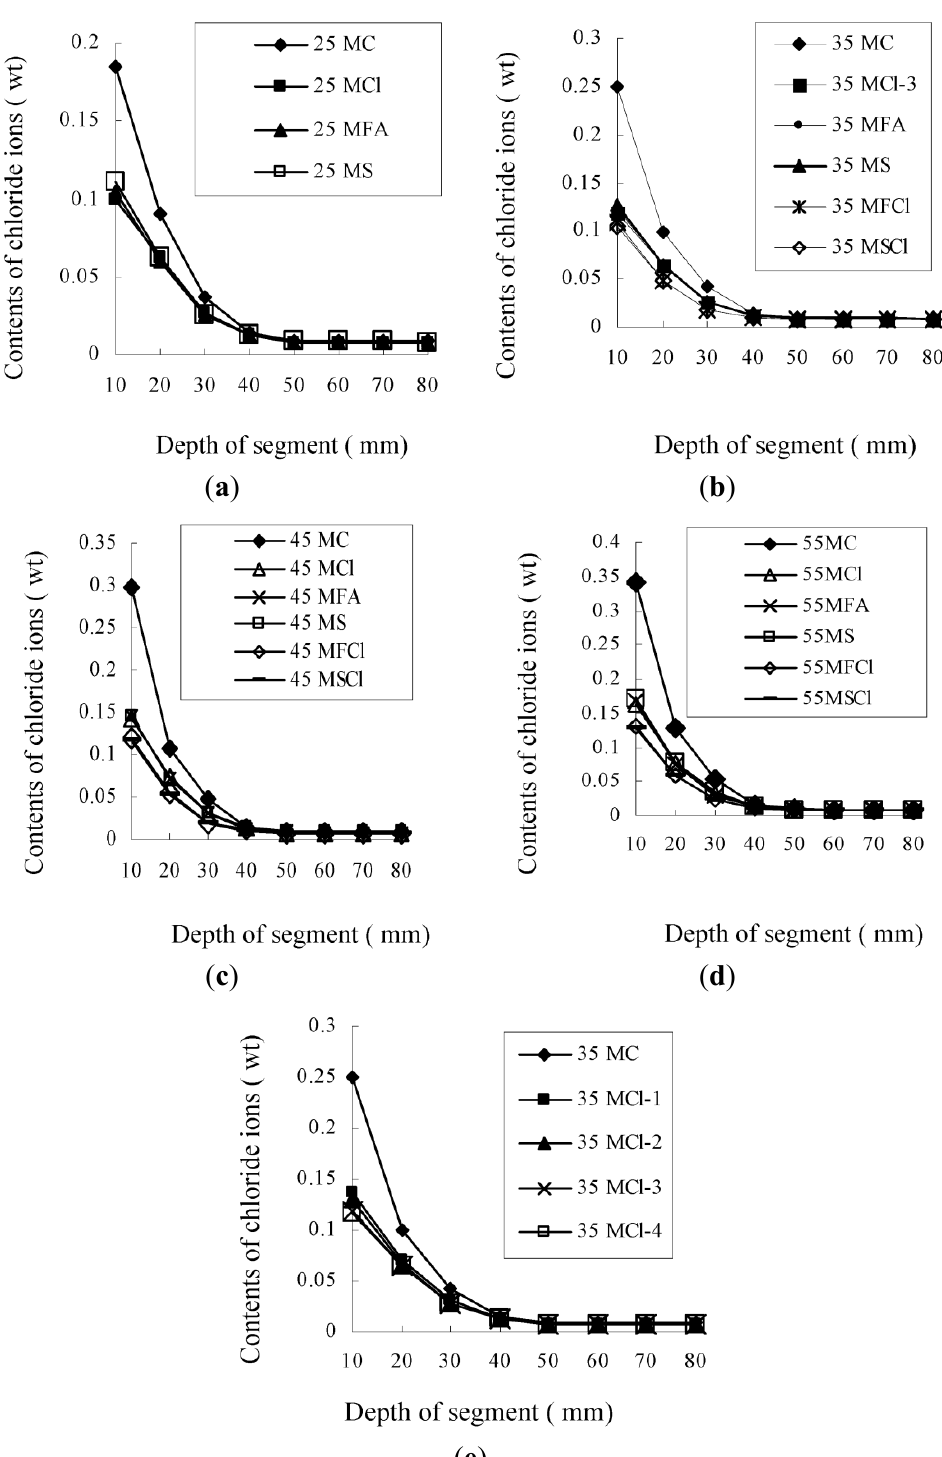
Figure 2. Results of contents of chloride ions in a series of segments of mortar, with a depth of 10–80 mm. ( a ) Mortar at 0.25 W/B ratio; ( b ) Mortar at 0.35 W/B ratio; ( c ) Mortar at 0.45 W/B ratio; ( d ) Mortar at 0.55 W/B ratio; ( e ) Mortar at 0.35 W/B ratio, incorporating the Cl agent at various